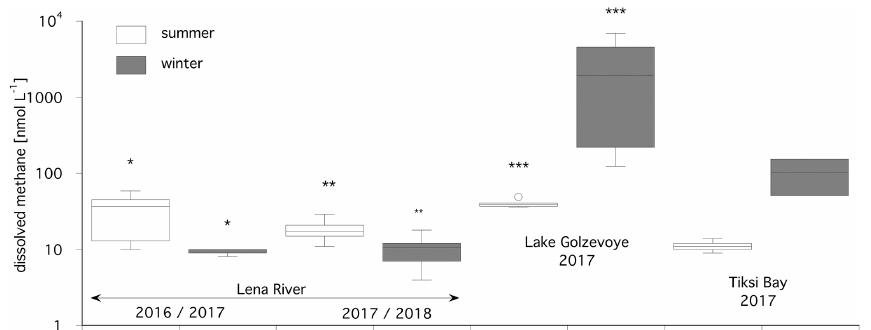
Figure 2. Median summer and winter methane concentrations at the Lena River, Lake Golzovoye, and Tiksi Bay in the years 2016–2018. Bright columns indicate summer values, and dark columns indicate winter values. The asterisks indicate significant differences between summer and winter data.